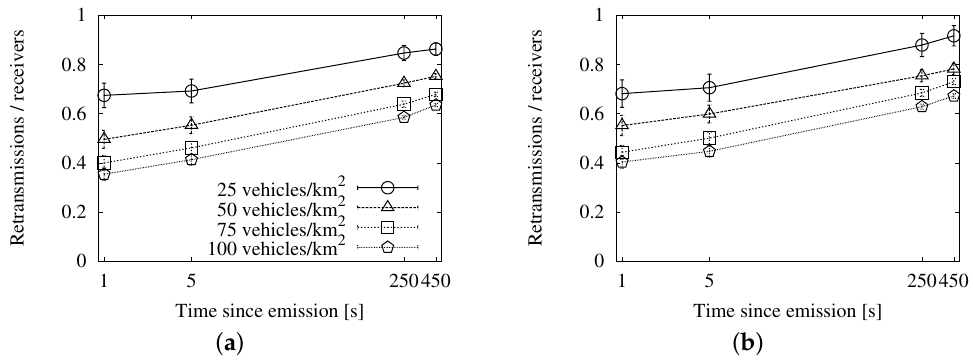
Figure 9. Forwarding ratio or the relation between sent duplicates and receivers with the speed-adaptive approach for store-carry-forward in the New York scenario: ( a ) roadway scheme. ( b ) map-based scheme.